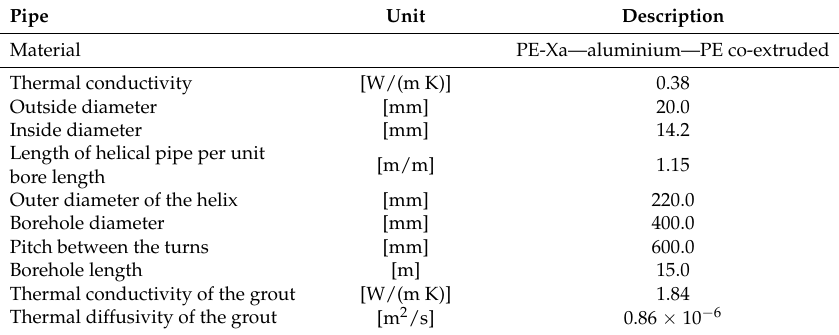
Table 4. Characteristics of the helical shaped pipe heat exchanger (Borehole D).